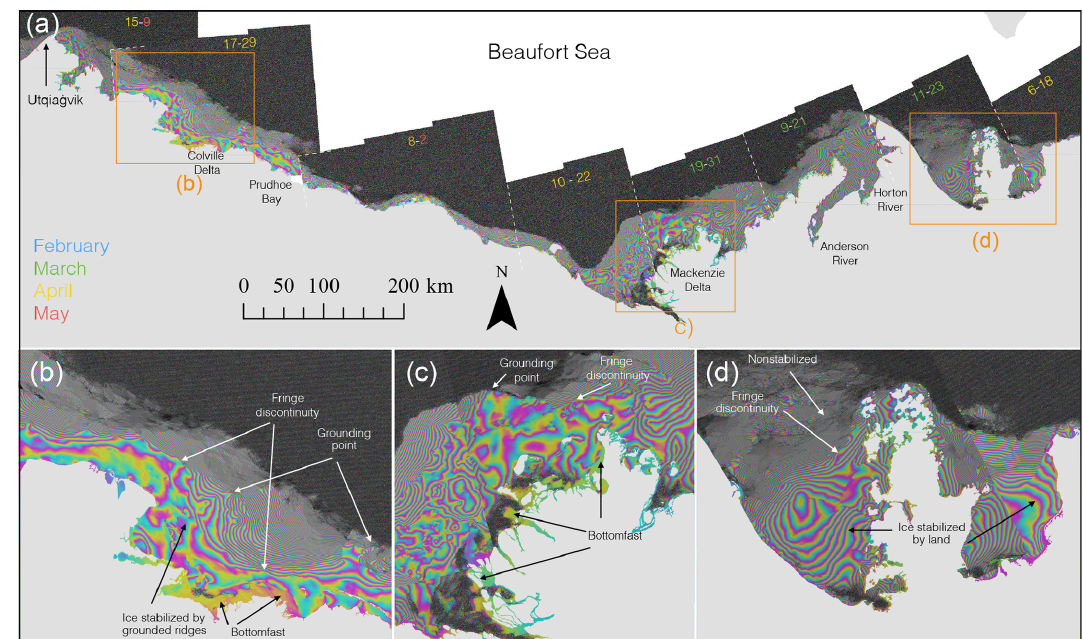
Figure 4. (a) Sentinel-1 interferograms derived from image pairs acquired over the Beaufort Sea between March and May 2017. Numbers on images represent date ranges. The colors blue, green, yellow, and red signify the months of February–May. (b, c, d) Three enlarged areas identified in (a) are further discussed in the